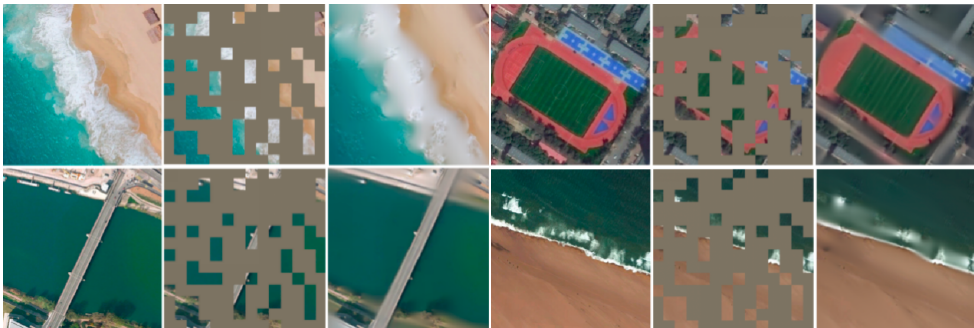
Figure 3. Reconstruction of masked images via self-supervised learning. Every four images is a group. ( Left ) Original image. ( Middle ) Random sampling for mask. ( Right ) Self-supervised model to reconstruct the